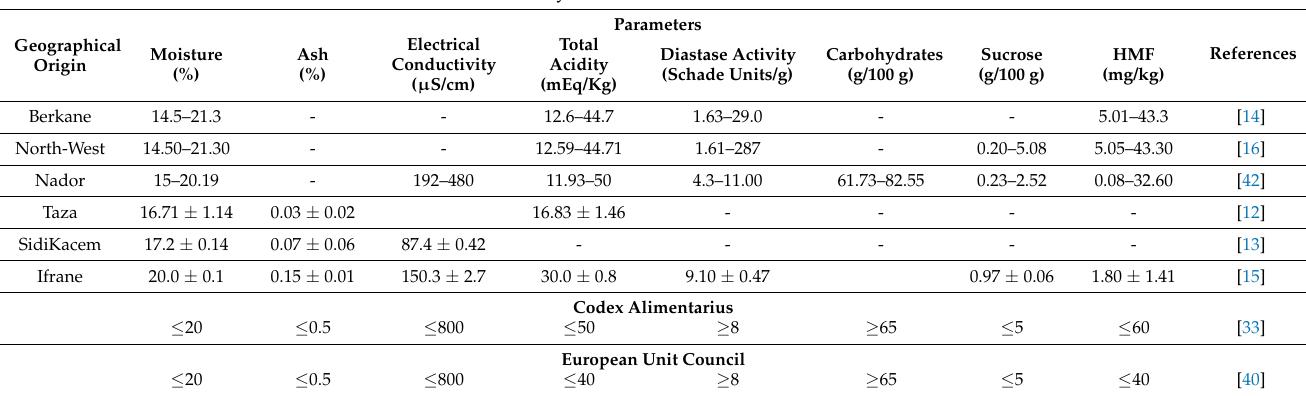
Table 4. Review of the quality criteria of Moroccan honeys with a predominance of Citrus pollen: comparison with international